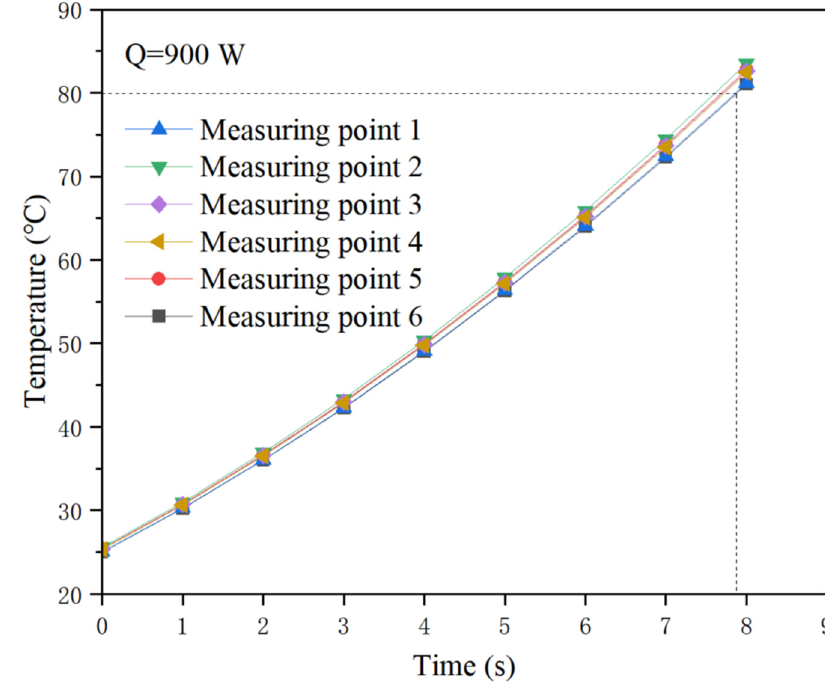
Figure 7. Temperature rise of measuring points without water cooling.